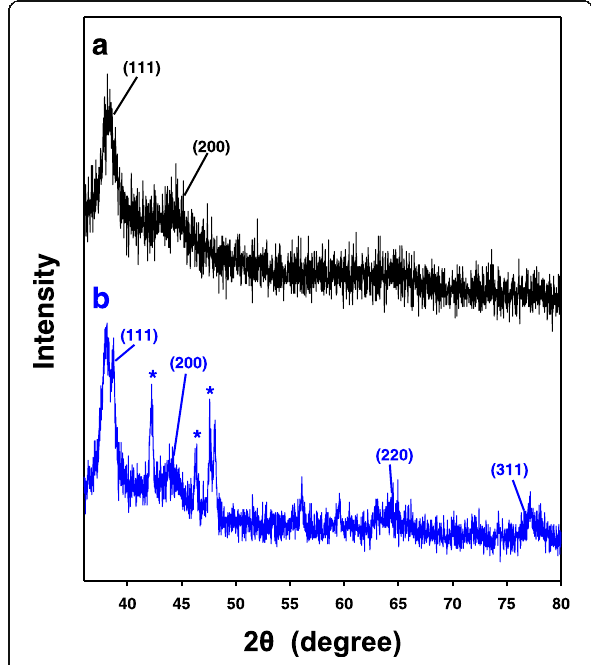
Fig. 8 HR-XRD analyses. a PD-AuNPs. b